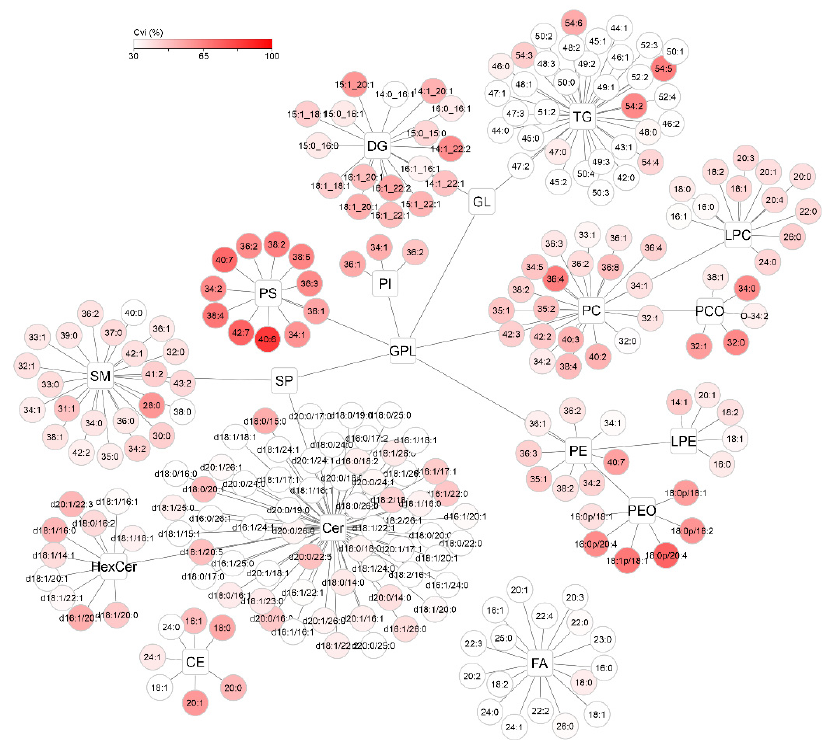
Figure 8. Cytoscape visualization of intraindividual variability (CVi, %) for all detected lipids after applying lnPQN transformation. The depth of color represents increasing relative variability (%).